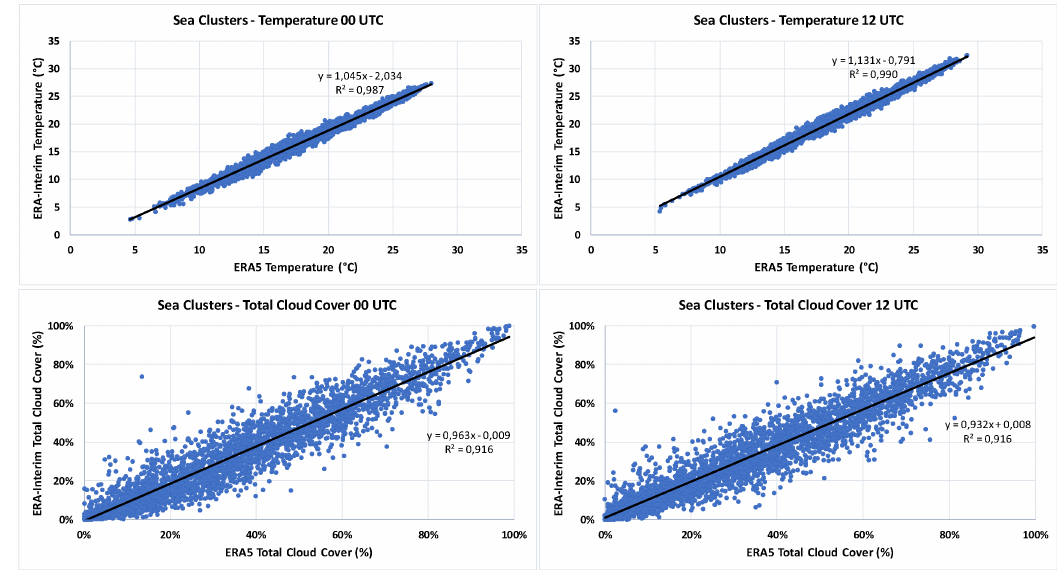
Figure 11. As in Figure 10, but for clusters 1–6 and 8–9 (sea areas).